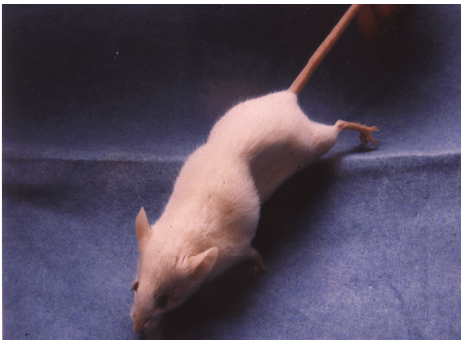
Figure 1: Mouse with classical “wasp waist” sign after intoxication with botulinum toxin (picture by courtesy of Professor F. Aller- berger, AGES